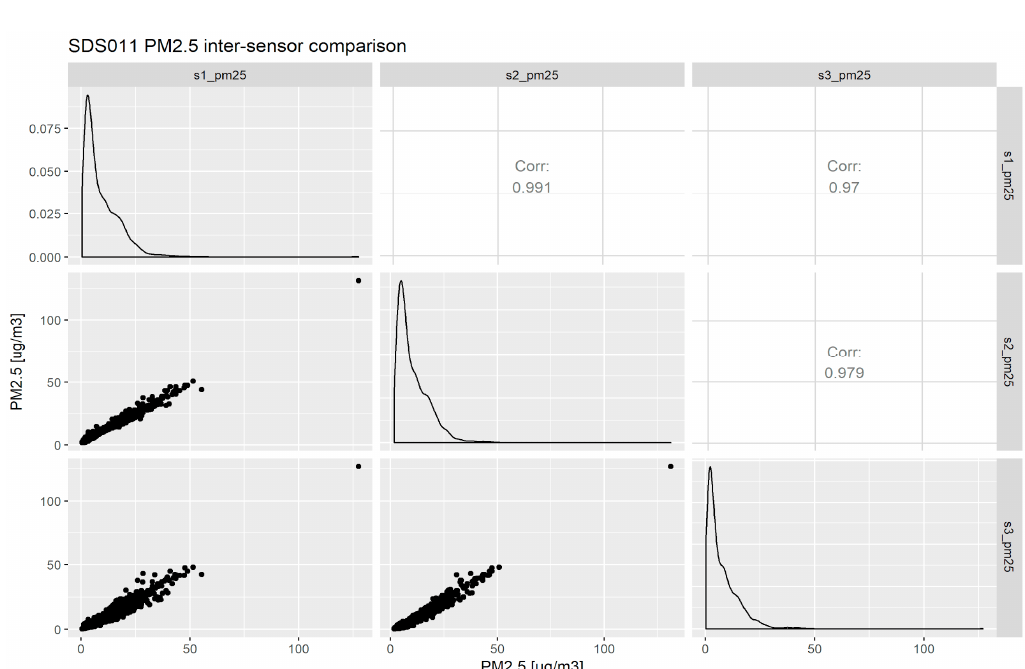
Figure 7. Inter-sensor variability for three SDS011 sensors visualized as a scatterplot matrix. The lower left half indicates the actual scatterplot of hourly PM 2.5 observation between all three sensors. The plots in the diagonal show the probability density function for each individual sensor. The upper right half shows the correlation between each sensor pair given as the Pearson R value.